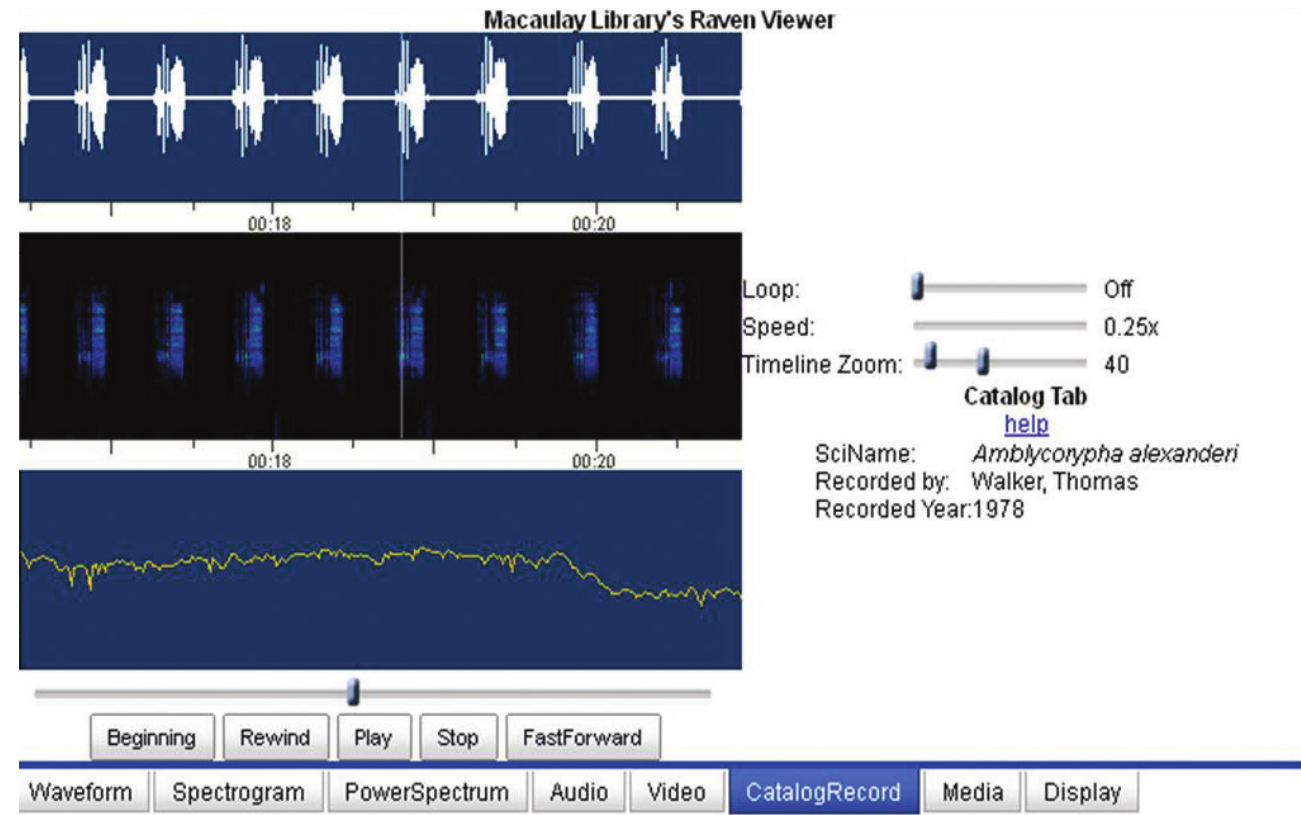
Fig. 1. Web-based sound analysis tool for the Macaulay Sound Library, Cornell Lab (https://www.macaulaylibrary.org). Macaulay Library provides more than 400,000 playable audio files (http://macaulaylibrary.org/index.do), and even permits spectrographic on- line visualization using RavenViewer as a free browser plugin (http://www.birds.cornell.edu/brp/software/sound-analysis-tools). The example shows a recording of a Virtuoso katydid by T. Walker, who provided most of the Orthoptera sound recordings for this sound library. For further details, see